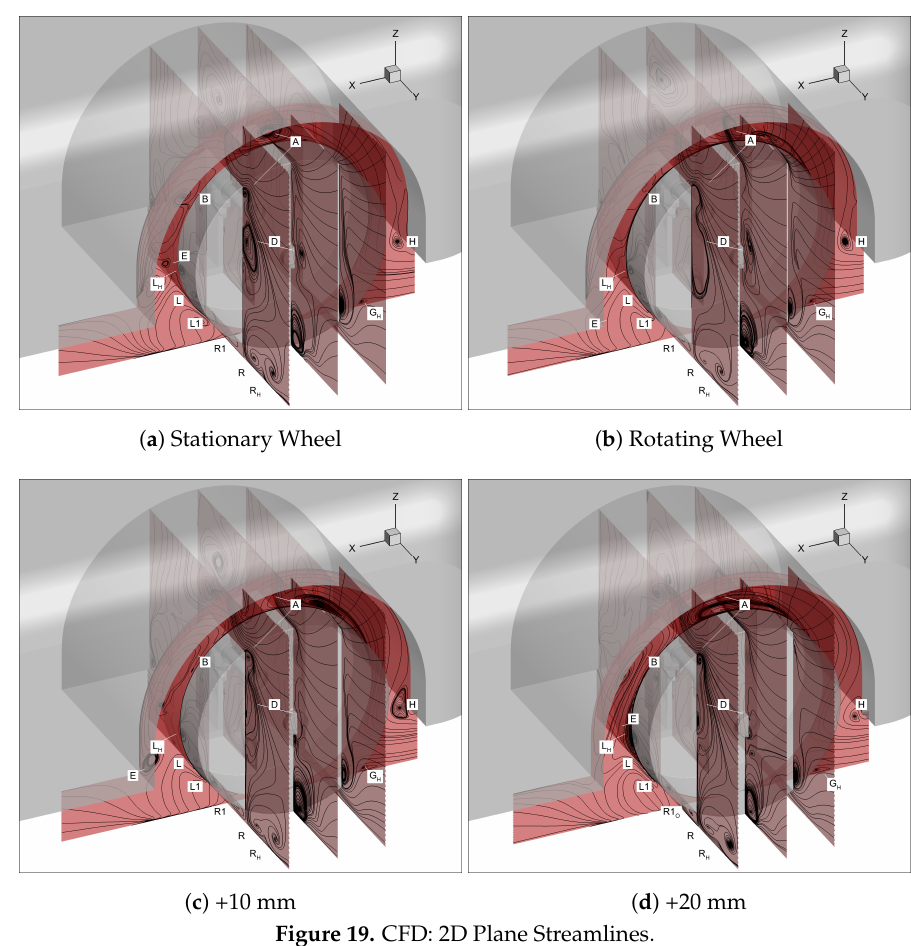
Figure 19. CFD: 2D Plane